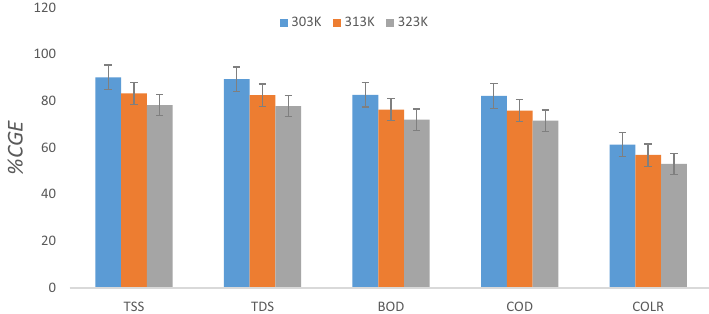
Figure 8. Effect of temperature on pollutants reduction at settling 60 min, 0.2 g L −1 , and pH 4.